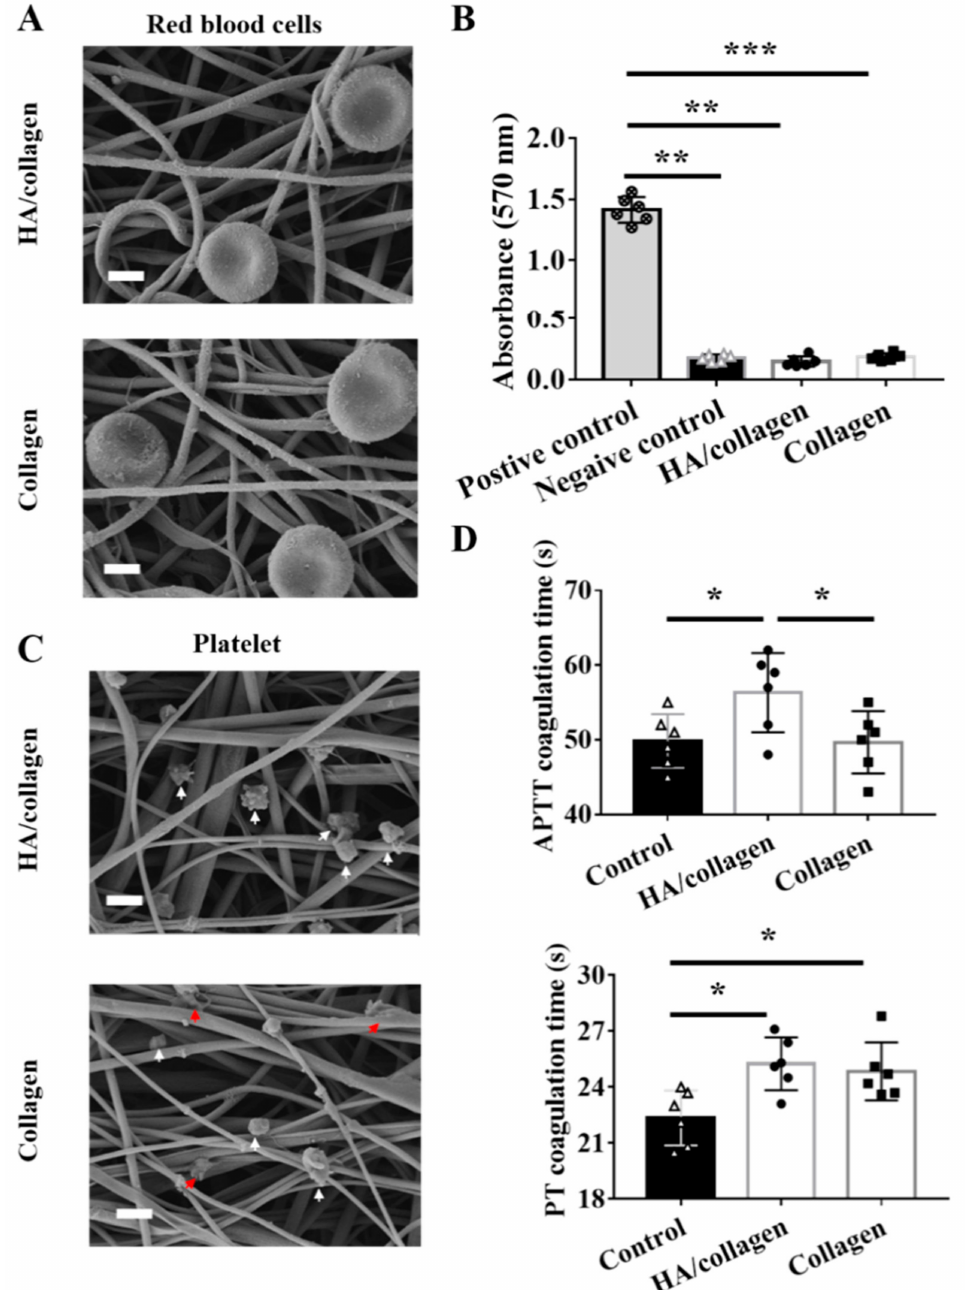
Figure 4. Hemolysis and anticoagulation tests. Representative SEM micrographs of red blood cells ( A ) and platelets ( C ) on HA/collagen and collagen nanofibers after 2 h seeding. White arrows indicate non-adherent platelets, red arrows indicate adherent platelets. Scale bars: 1 µ m. Hemolysis rate ( B ) of different nanofibers. Statistical data of APTT and PT ( D ) of control native plasma and plasma incubated with different nanofibers. n = 3, * p < 0.5; ** p < 0.01; *** p <